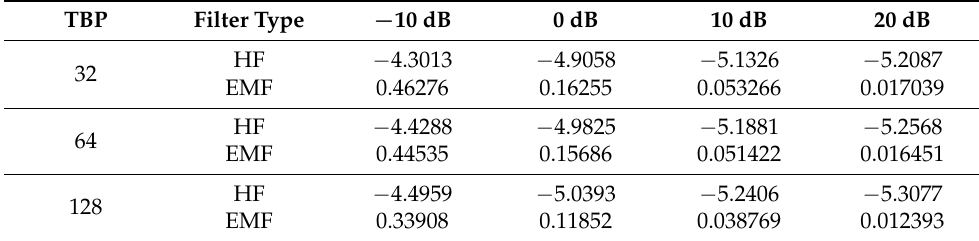
Table 2. Mainlobe loss ratio (MLR) for HF, and the proposed EMF.